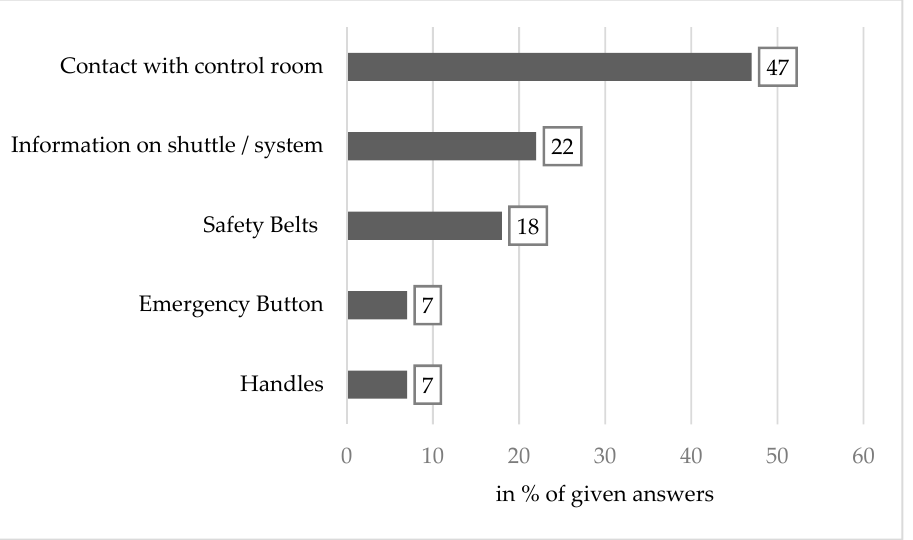
Figure 4. Suggestions for increasing perceived safety (“What would contribute to your feeling of safety?”).